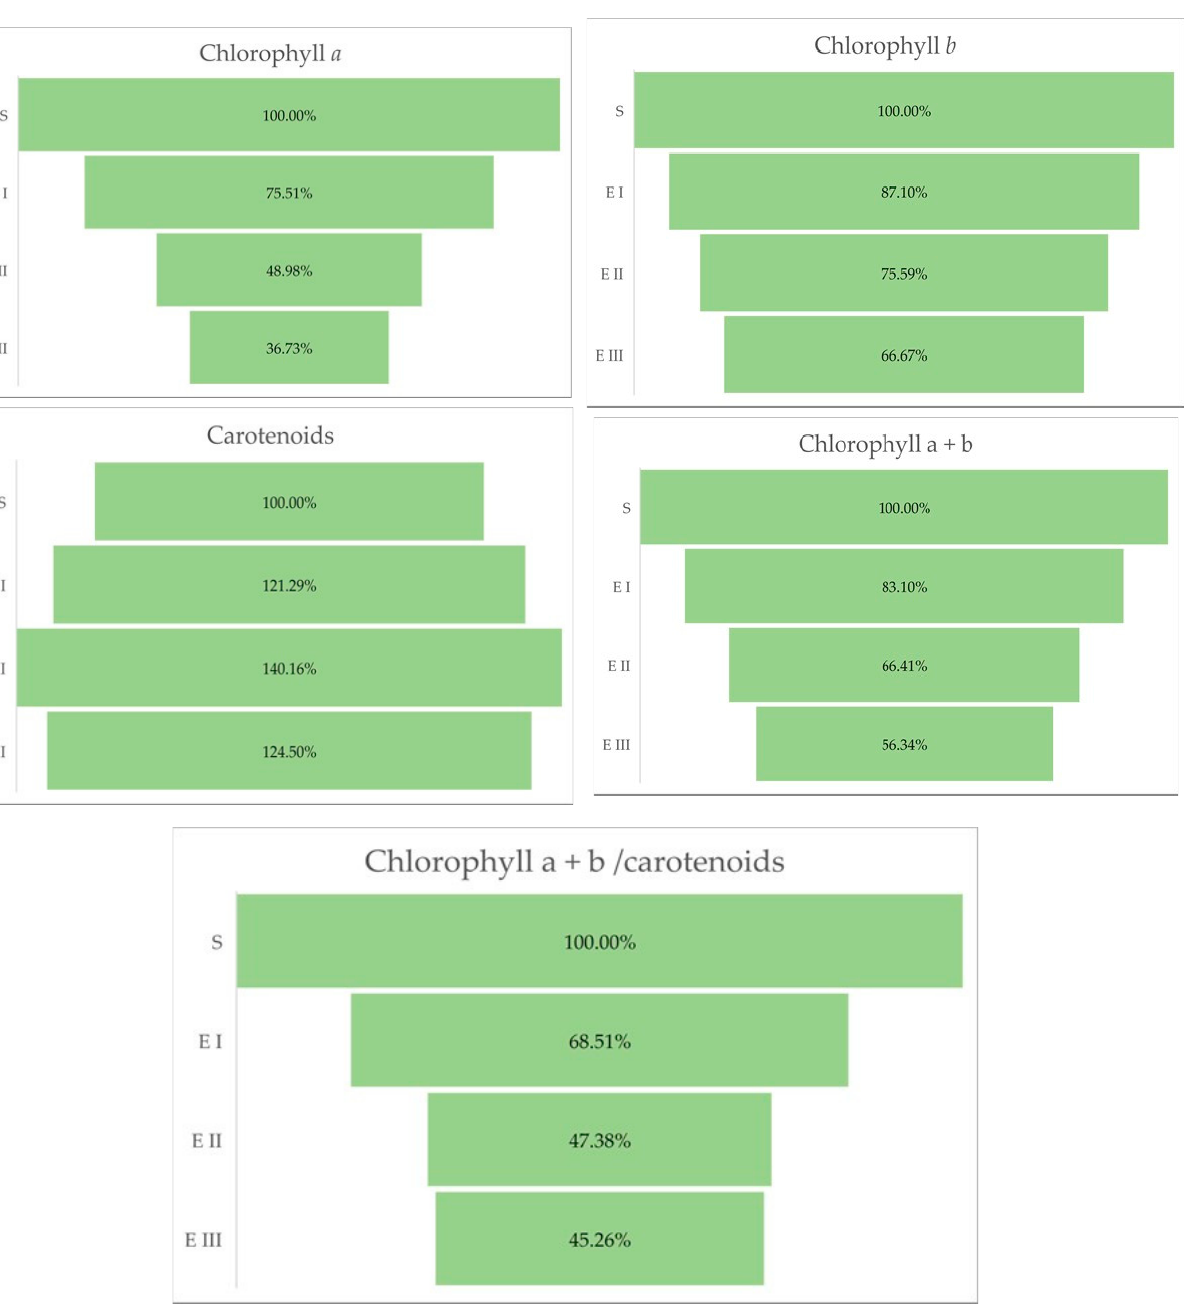
Figure 3. Chlorophylls a, b, and carotenoids (%) in different stages of the disease. Legend: S—healthy